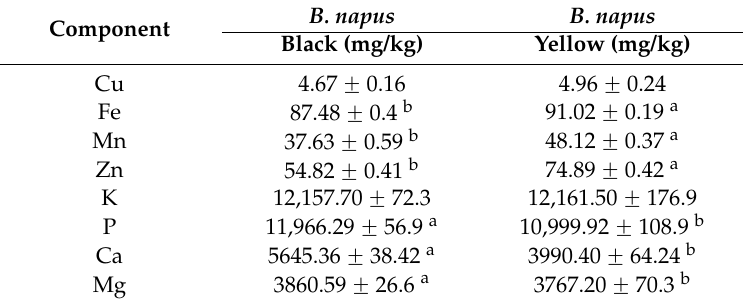
Table 3. The element composition of black- and yellow-seeded B. napus seed